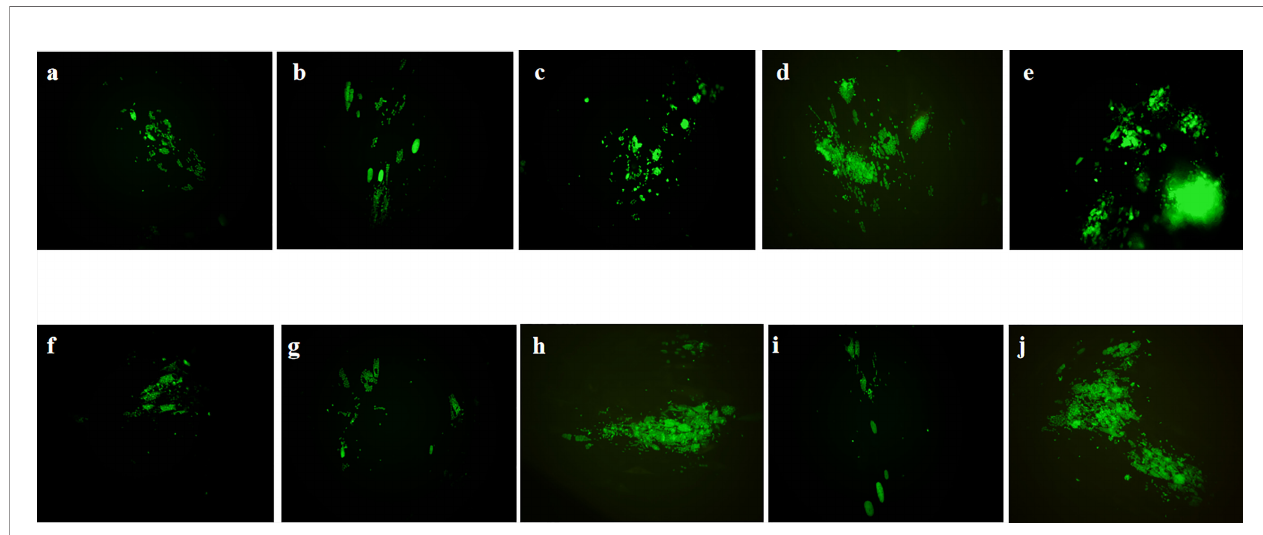
FIGURE 3 | Anti- T. gondii activity of Ov EO and Ca evaluated by growth assay. Fluorescence area indicates the growth of T. gondii during different treatment. (A – D) Different concentrations of Ov EO, (A) 70 m g/ml, (B) 35 m g/ml, (C) 17 m g/ml, (D) 9 m g/ml, and (E) no treatment; (F – H) Different concentrations of Ca, (F) 17 m g/ml, (G) 9 m g/ml, (H) 4 m g/ml, (I) SMZ, and (J)